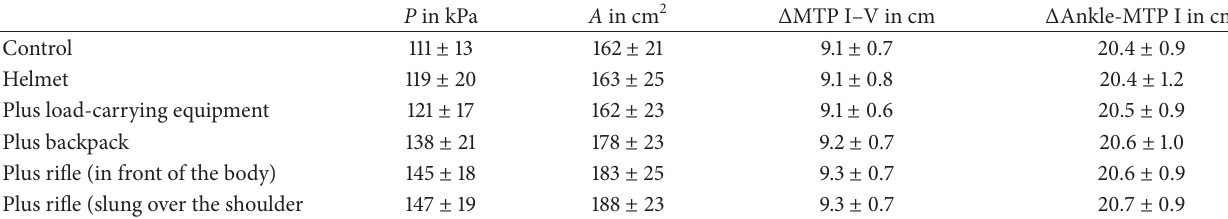
Table 7: Static measurement results for contact area ( A ), pressure ( P ), distance from the first to the fifth metatarsal caput (MTP I–V), and distance from the heel to the first metatarsal